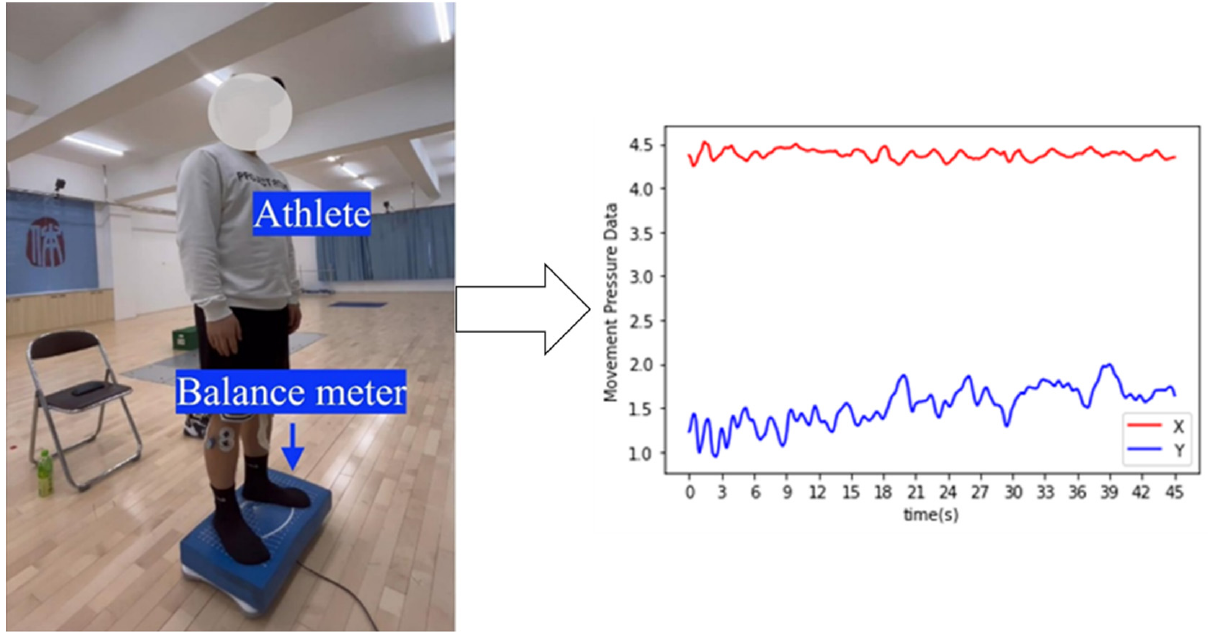
Figure 1. The scenarios of the athlete movement pressure data collection experiments. The levels of balance control ability are divided into four classes. Specifically, they people from different groups, including top freestyle skiing athletes, professional skill athletes, normally trained students from non-skill sports, and common people. The four classes are denoted as A, B, C, and D, respectively. The balance control ability levels decrease from A to D. For instance, the A group has the best ability, and the B group has the second best ability. We select three athletes from each level, who are represented by #1, #2, and #3 respectively. The athletes are required to keep their upper bodies stationary to and use two feet while standing with their eyes closed, then to reduce their body